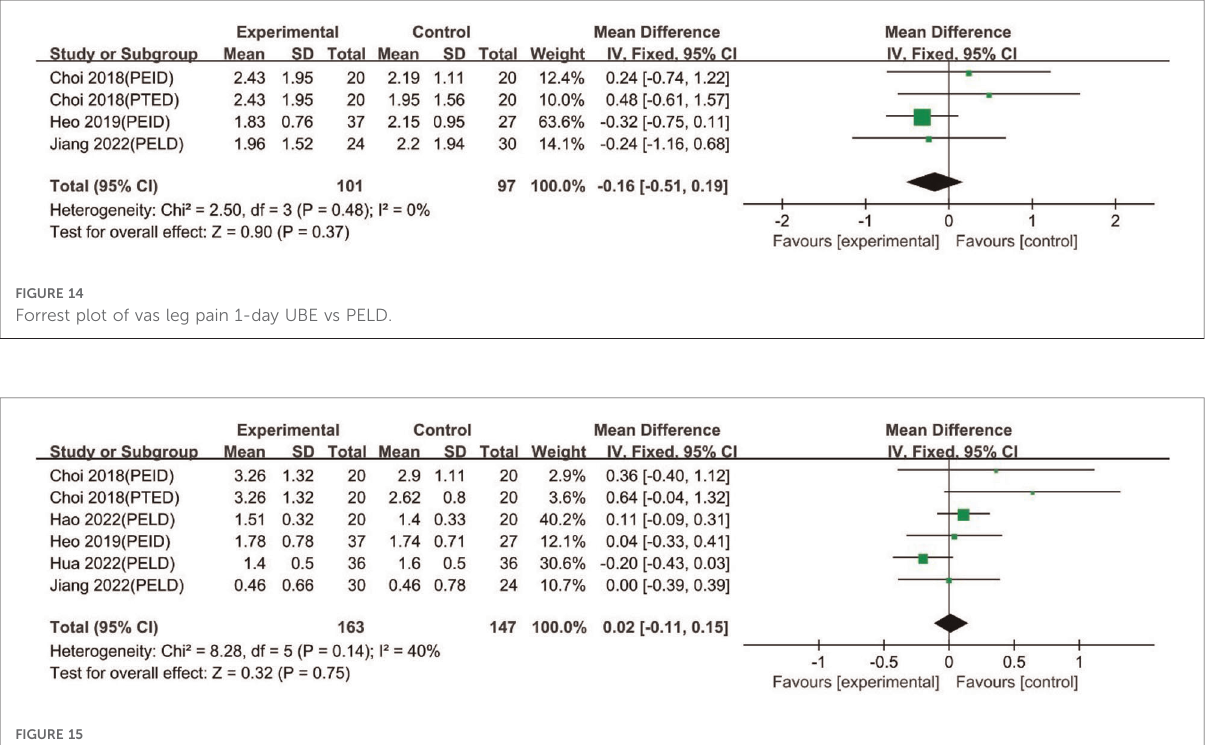
FIGURE 15 Forrest plot of long term vas back pain UBE vs PELD.